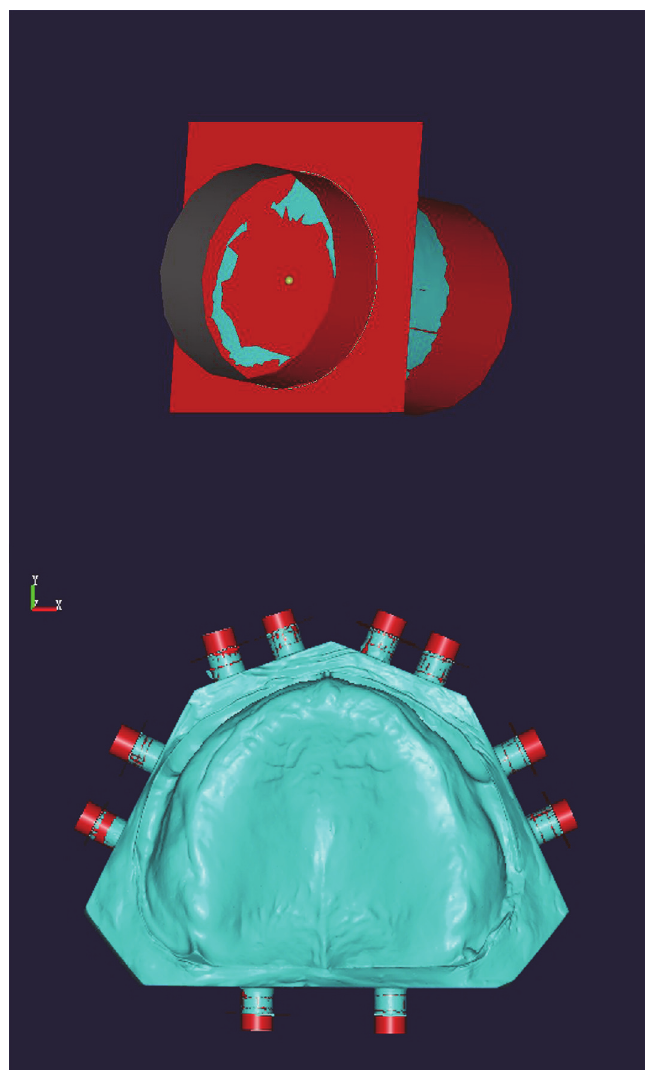
Fig 2. Determination of fitting method center